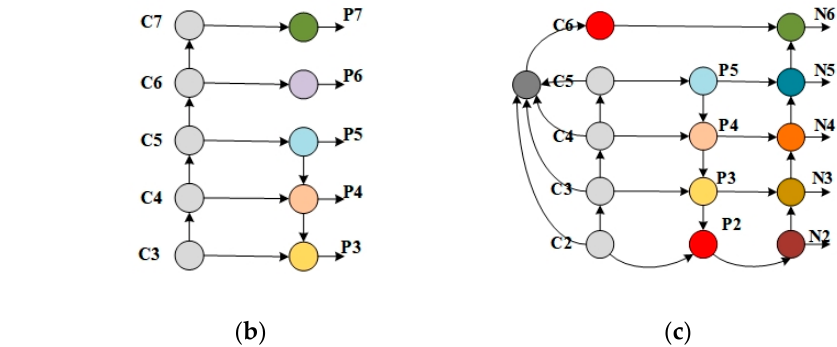
Figure 2. Comparisons of different backbone: ( a ) PANet; ( b ) RetinaNet; ( c ) BFE-Net (our model). This structure uses feature pyramid levels P2 to P6, where P3 to P5 are obtained from the corresponding ResNet residual stages (C3 through C5) using top-down and lateral connections as in RetinaNet [11]. P6 is obtained through HGM, P2 is obtained by using DFE to enhance the C2 feature and then connecting it laterally with P3, which is different from [11]. N2 to N5 are obtained from the corresponding P2 to P5 via lateral connections and bottom-up paths, as in PANet [20]. N6 is obtained by lateral connections with C6 by stride convolution instead of down sampling (Figure 3a), which is different from [20].